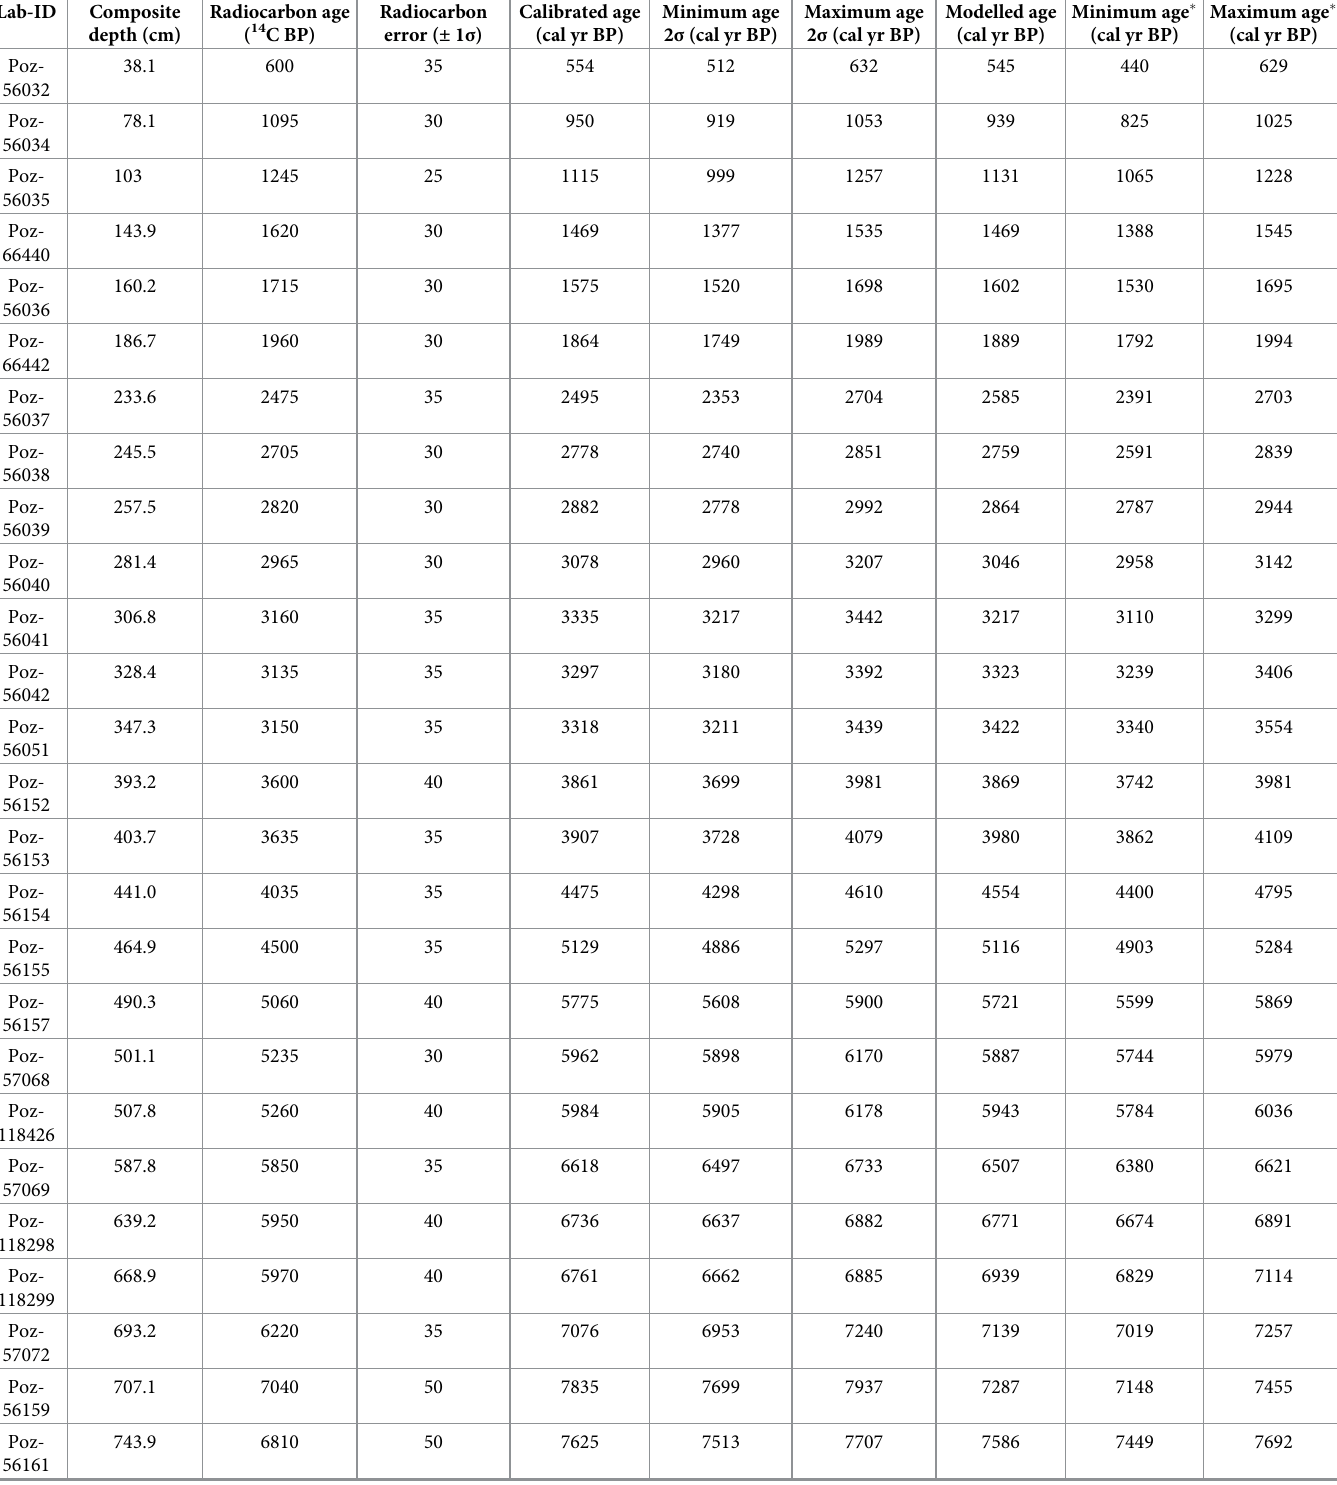
Table 1. AMS radiocarbon dates from the CTP calibrated with CALIB 8.2 [38] and the Southern Hemisphere calibration curve (SHCal20, [37]). Modelled ages were obtained with age-depth modelling software Bacon